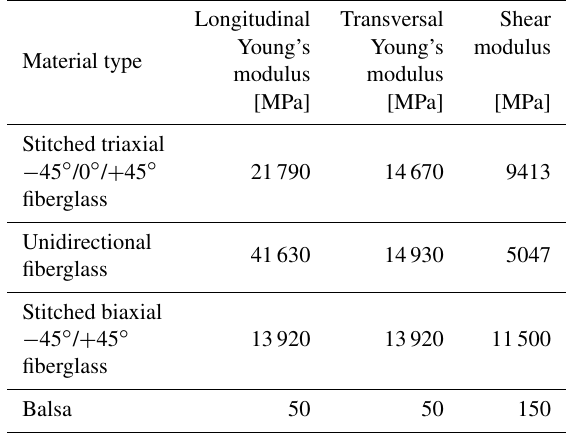
Table 8. Extent of the structural components and their materials for the 10MW wind turbine.